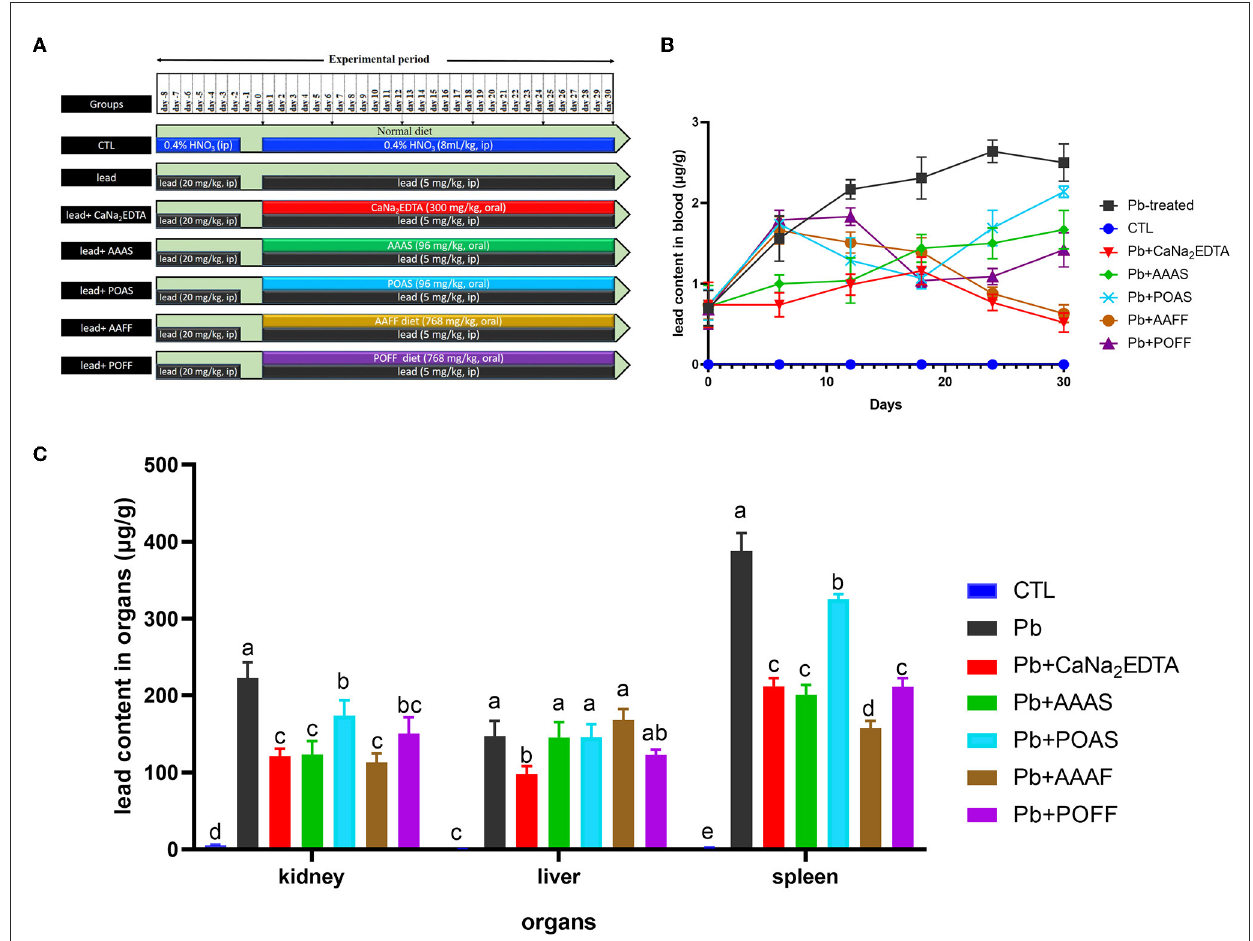
FIGURE4 Elimination of lead in the blood and organs of rats. (A) Treatment of rats from different groups. (B) Lead contents in the blood sample of rats. (C) Lead contents in different organs of rats. All values are represented as mean ± SD ( n = 5). Different letters for the same parameter are significantly different at P < 0.05 as revealed by